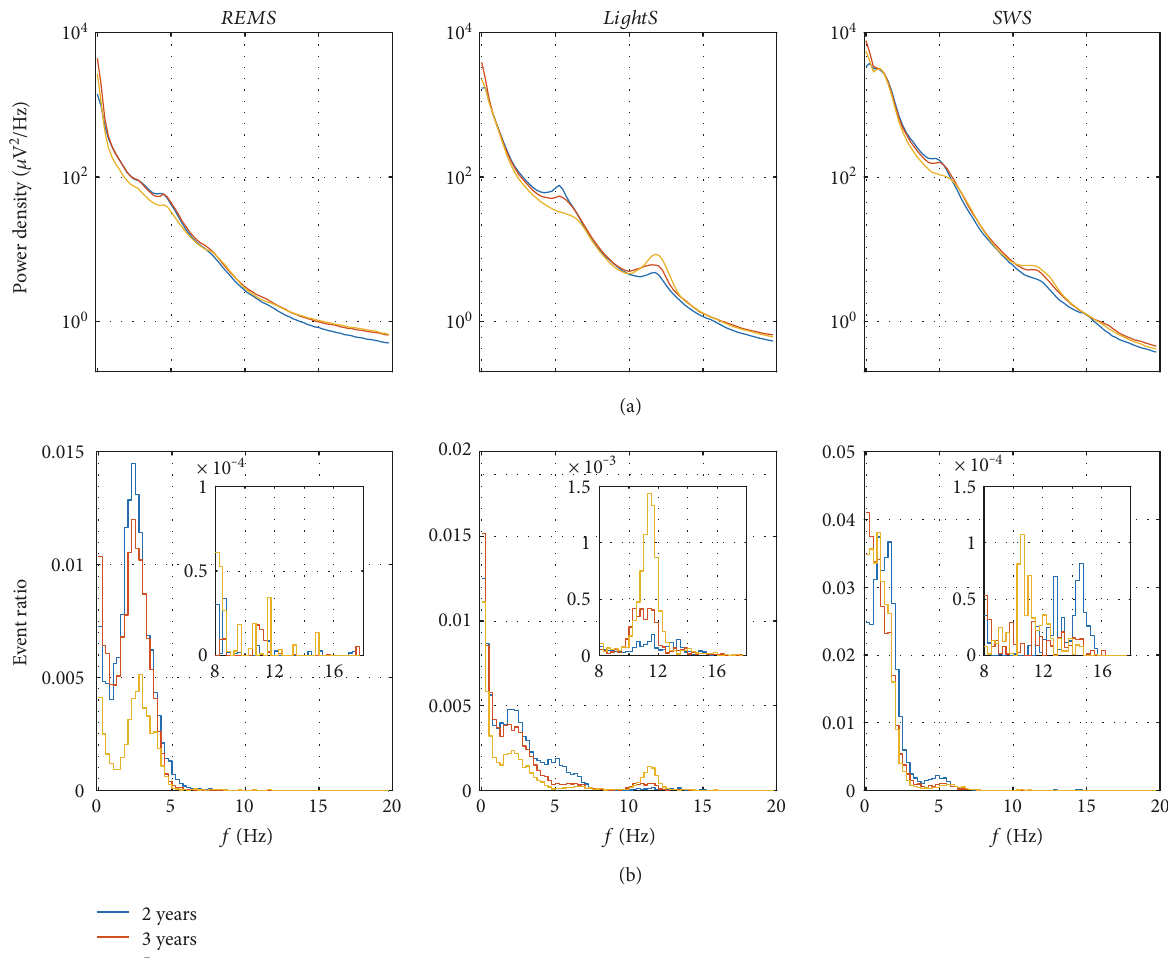
Figure 3: (a) Mean ( n = 8 ) power density spectra (geometric mean) and (b) event ratios of REM sleep (REMS), light sleep (LightS, NREM sleep stages 1 and 2), and slow-wave sleep (SWS, NREM sleep stages 3 and 4) recorded longitudinally at 2 (blue), 3 (red), and 5 years (orange) of age. The insets in the event ratios are a zoom into the 8 – 18Hz range, and the frequency axis of inset and main plot do correspond (e.g., 10Hz is at the same location in both plots). For a statistical assessment of the longitudinal changes in speci fi c frequency bands, see Figure